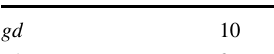
Table 7 Parameters of DMOEOA